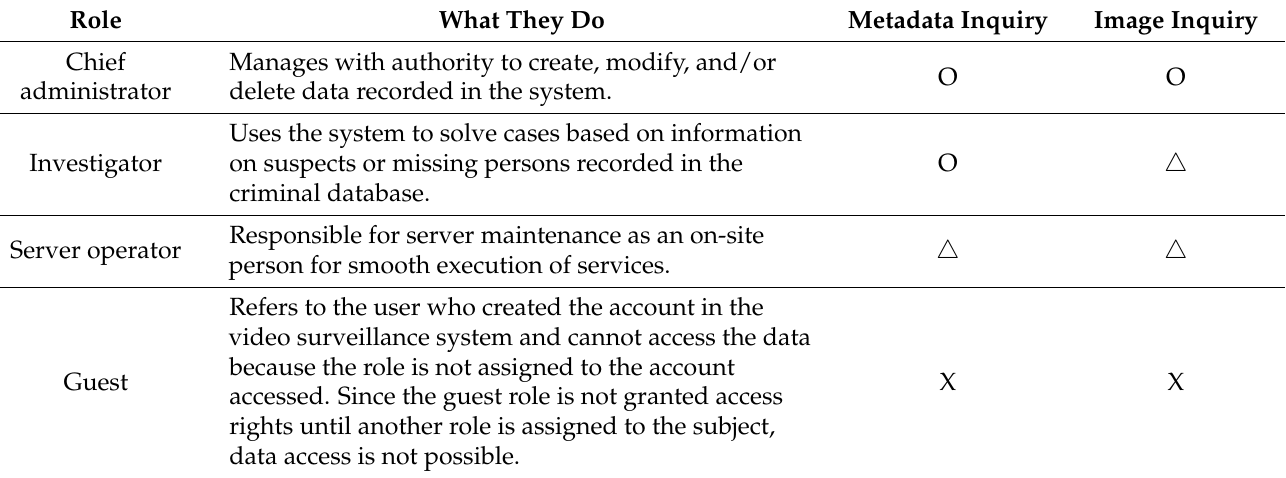
Table 2. Separation of user roles in the suggestion